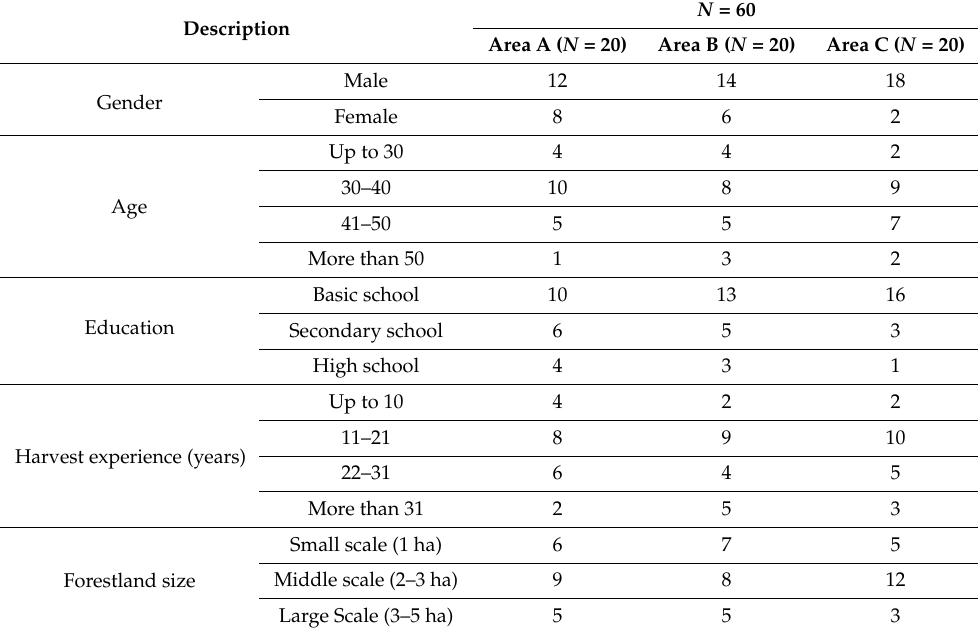
Table 1. Socio-demographic characteristics of the targeted farmers’ group of TAKTIK